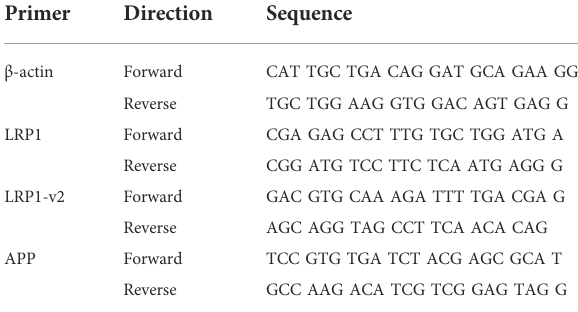
TABLE 1 List of primer sequences used in